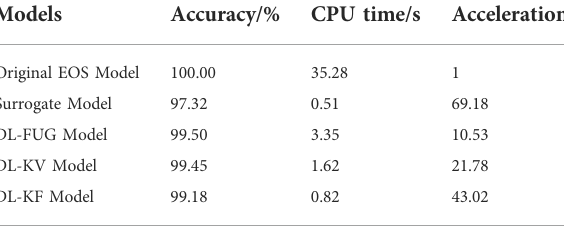
TABLE 3 Comparison of calculation results for different models (196 samples prediction).